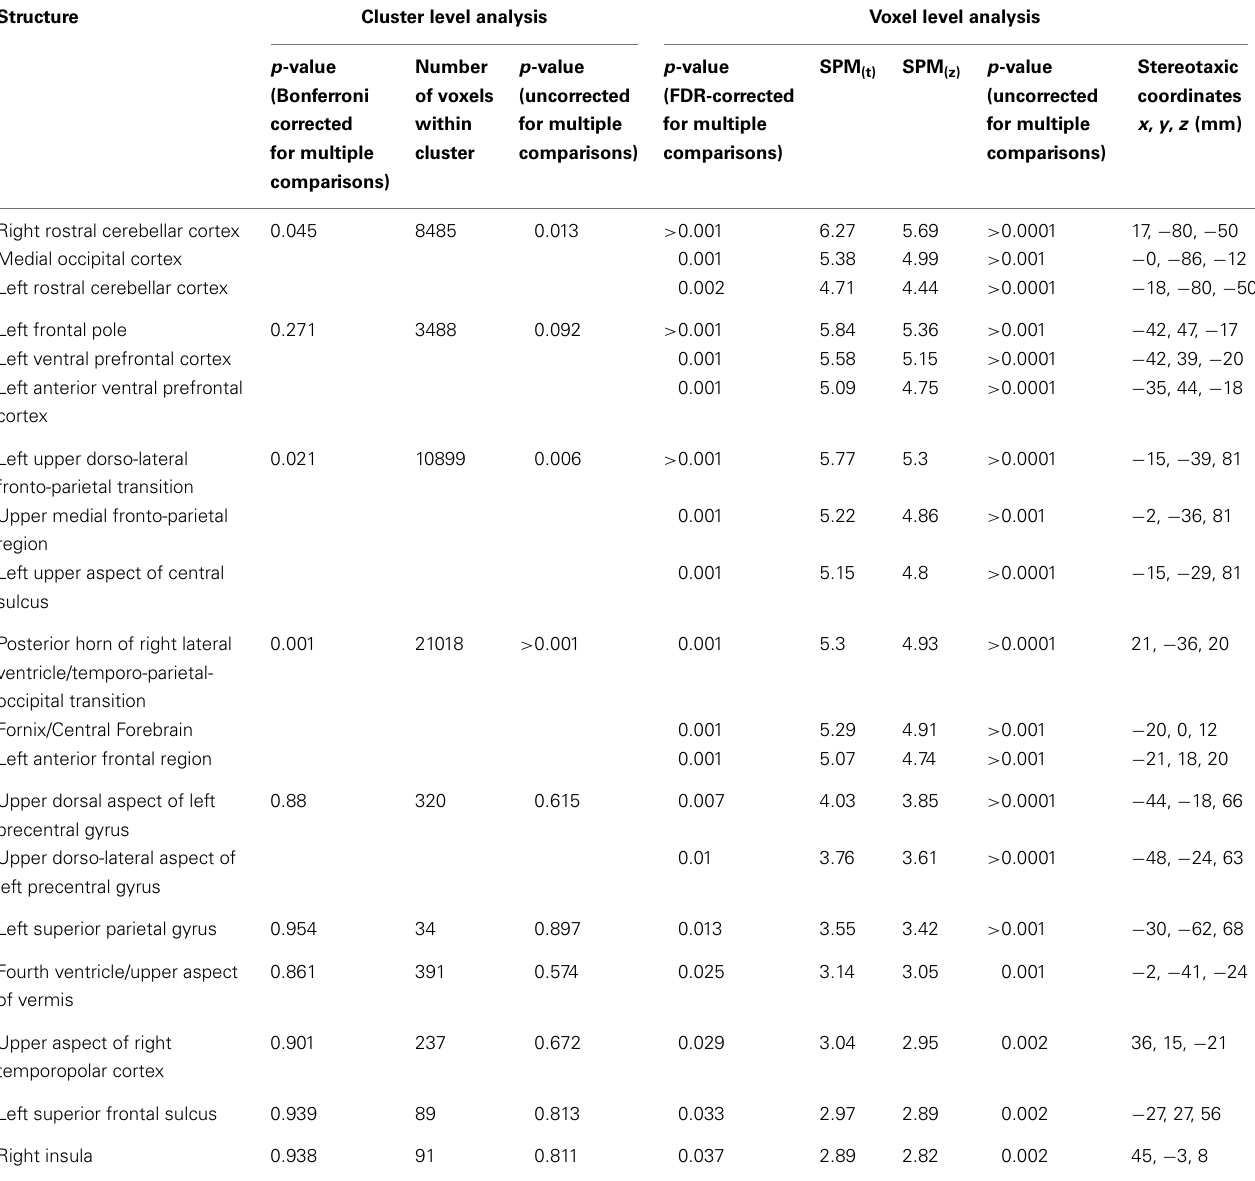
Table 1 | Results of the voxel-based comparison of SPECT images between controls and SCD patients .